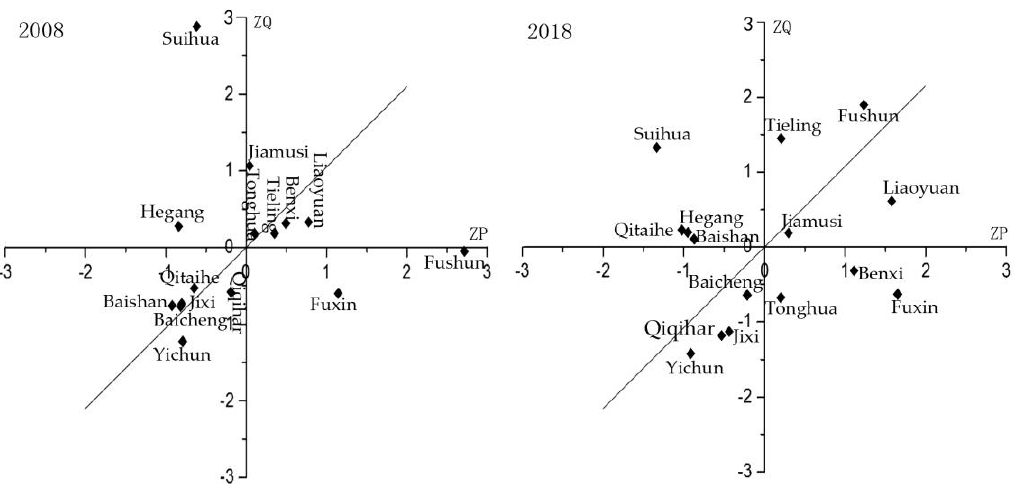
Figure 7. The quadrant diagram of coordinated relationship between compactness and land-use efficiency in 2008 and 2018. (Source: Authors).